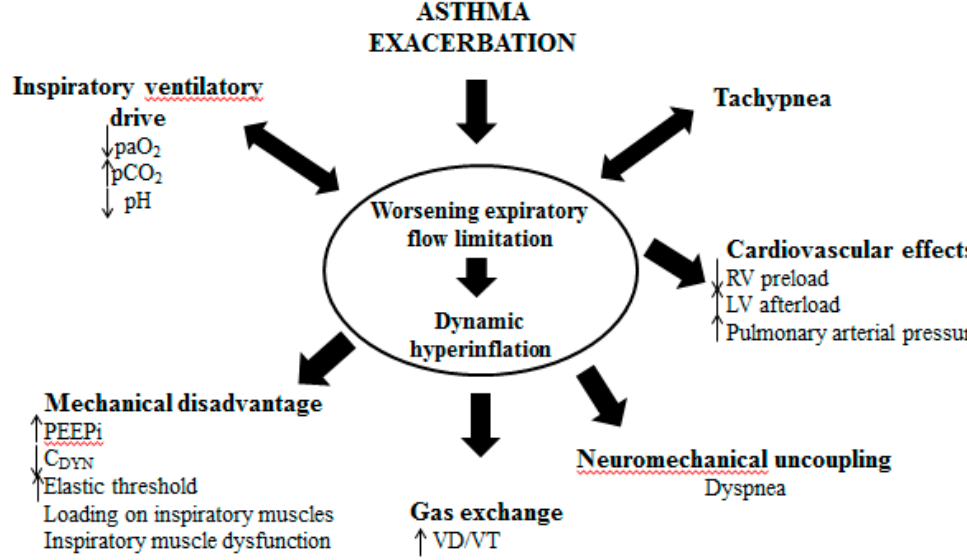
Figure 6. Pathophysiological changes due to dynamic hyperinflation.